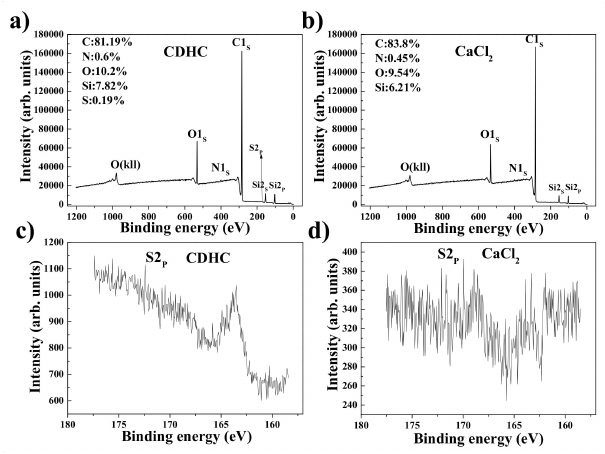
Figure 4. XPS wide scan and carbon narrow scan of the composites which coagulated by ( a ), ( c ) CDHC and ( b ), ( d ) CaCl 2 .